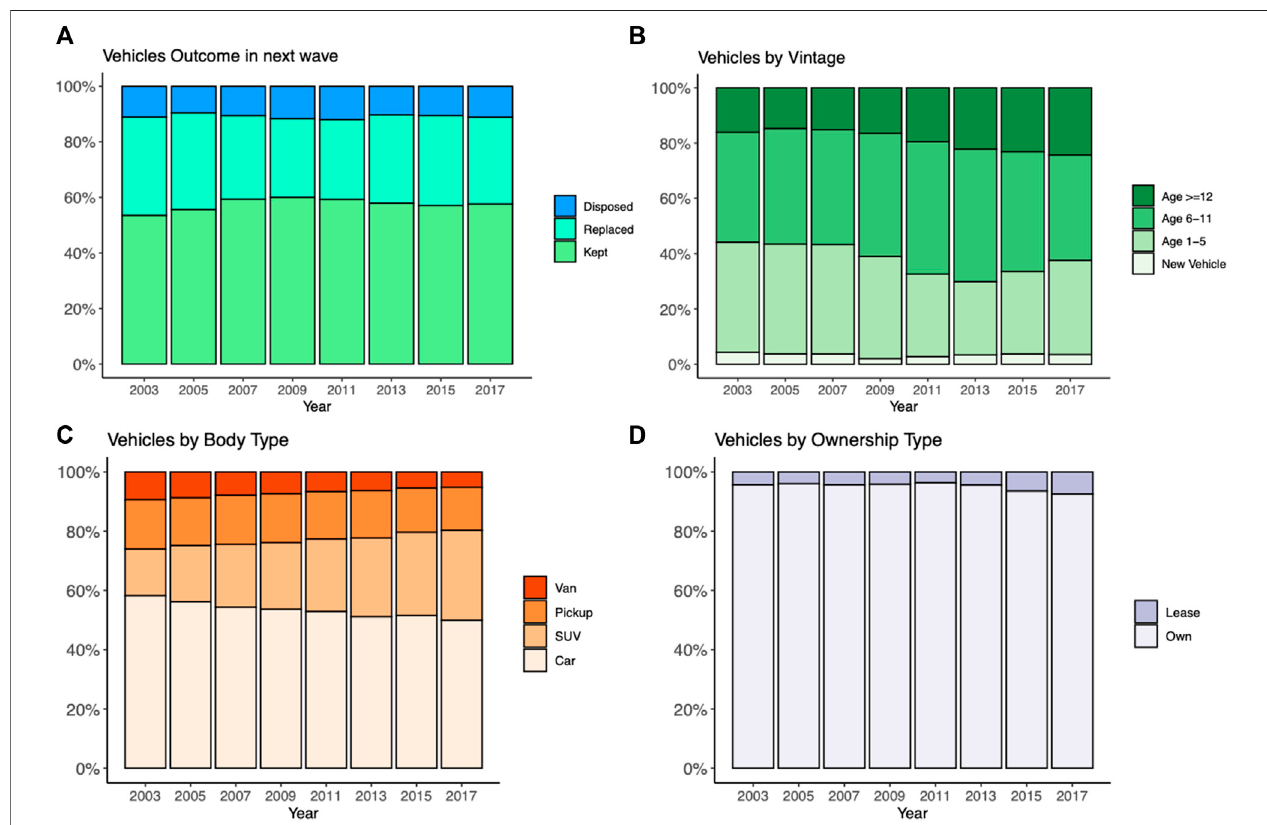
FIGURE 1 | Summary of distribution of vehicle variables by year: (A) vehicle outcome; (B) vehicle vintage; (C) vehicle body type; (D) vehicle ownership type.